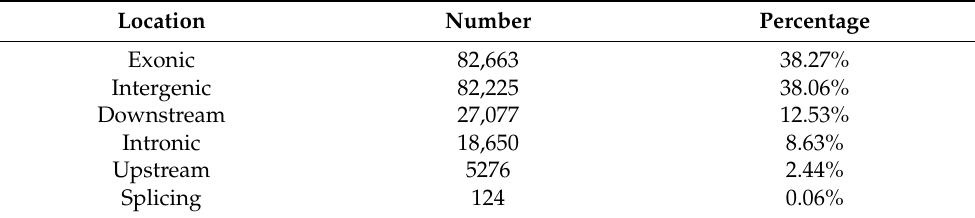
Table 4. Mutation location statistics for 216,015 hypothetical